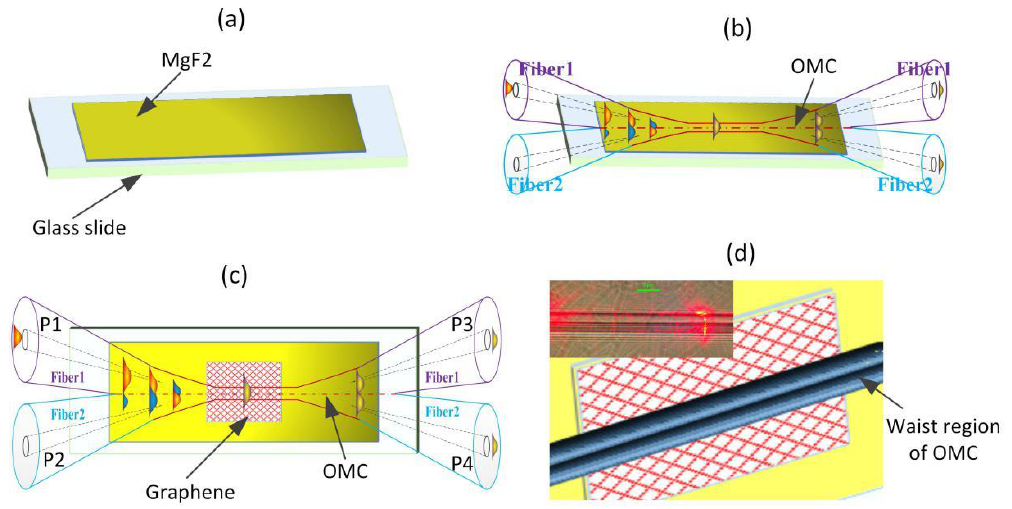
Figure 1. The preparation process of the GOMC: ( a ) evaporating MgF 2 onto the glass slide, ( b ) transfer graphene to the MgF 2 film, ( c ) the OMC was applied to a slide loaded with the graphene, and ( d ) the structure diagram and microscope photograph (insert image) of the OMC waist area and graphene bonding part.